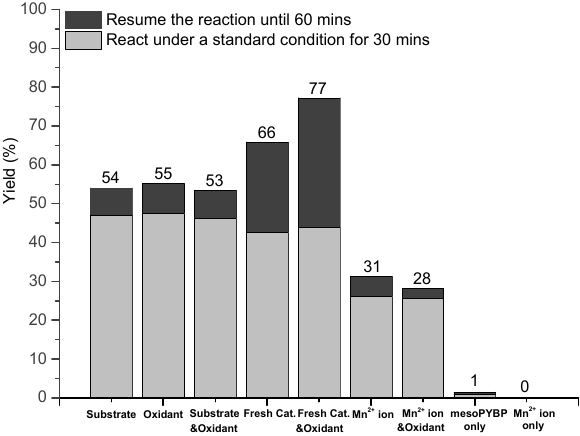
Figure 3. Limiting reagent test by GC for Complex 2 catalyzed epoxidation.